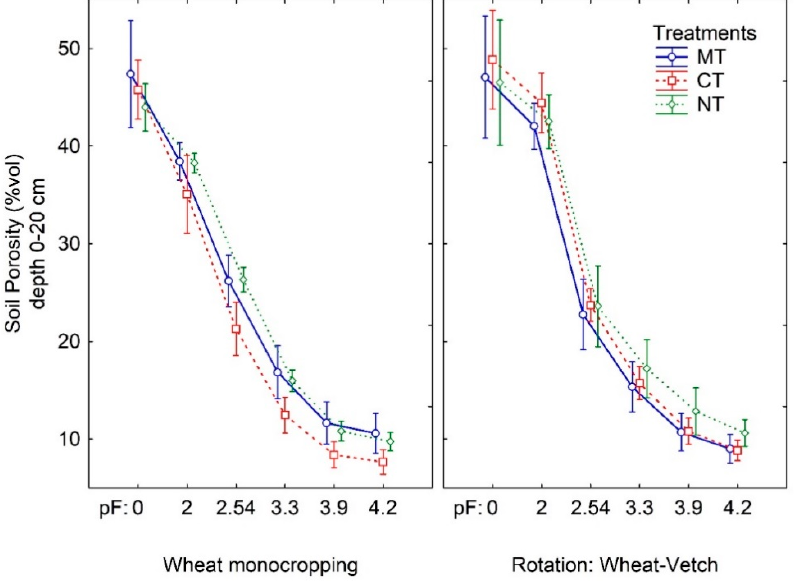
Figure 2. Water retention curves of soils considering 0 to 20 cm depth and different tillage treat- ments, conventional tillage (CT), minimum tillage (MT) and no-tillage (NT) and rotations. conventional tillage (CT), minimum tillage (MT) and no-tillage (NT) and